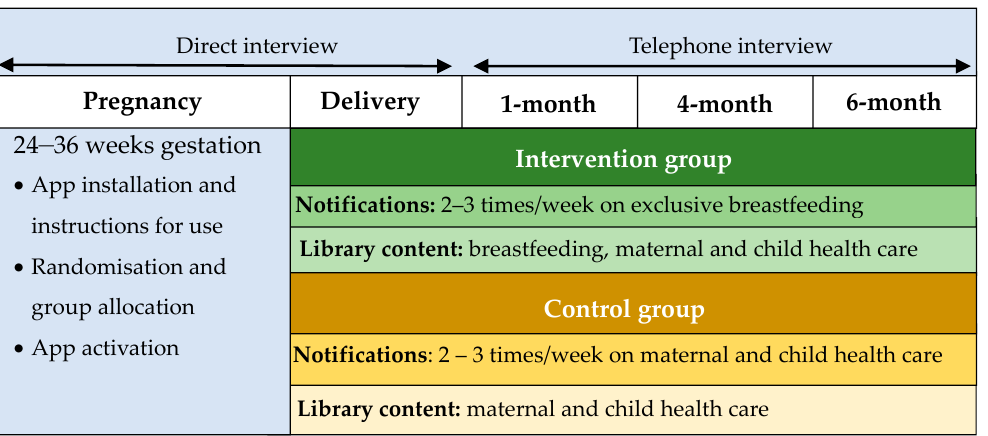
Figure 1. Study design and interventions.